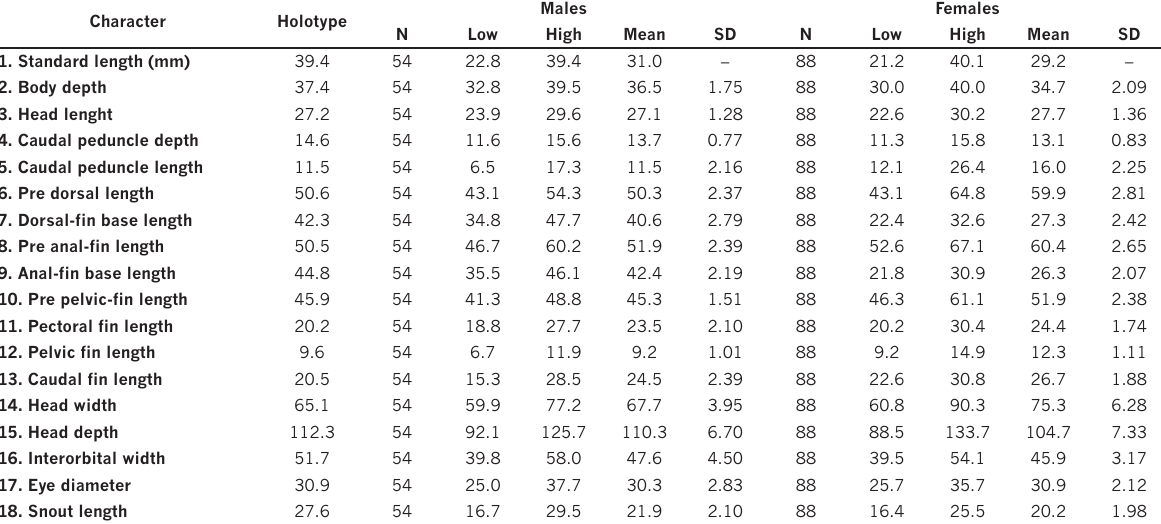
Table 1. Morphometric data of Austrolebias queguay sp. n., Standard length is expressed in mm; measurements numbered 2–13 are percentage of standard length; subunits of head measurements (numbered 14–18) are percentage of Head length. Ranges presented for males include the